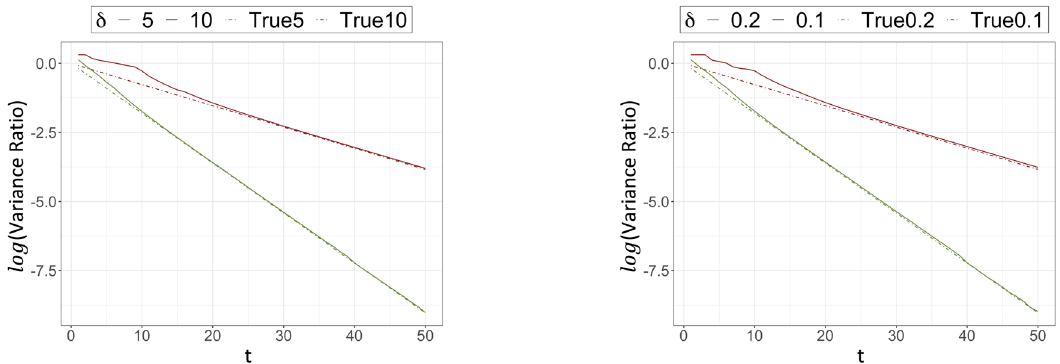
Figure 1: Variance ratio in log - scale over t for the always - treated with δ 5, 10 = ( Left ) , and for the never - treated with δ 0.2, 0.1 = ( Right ) . The true lower bounds for each δ are represented by dotted